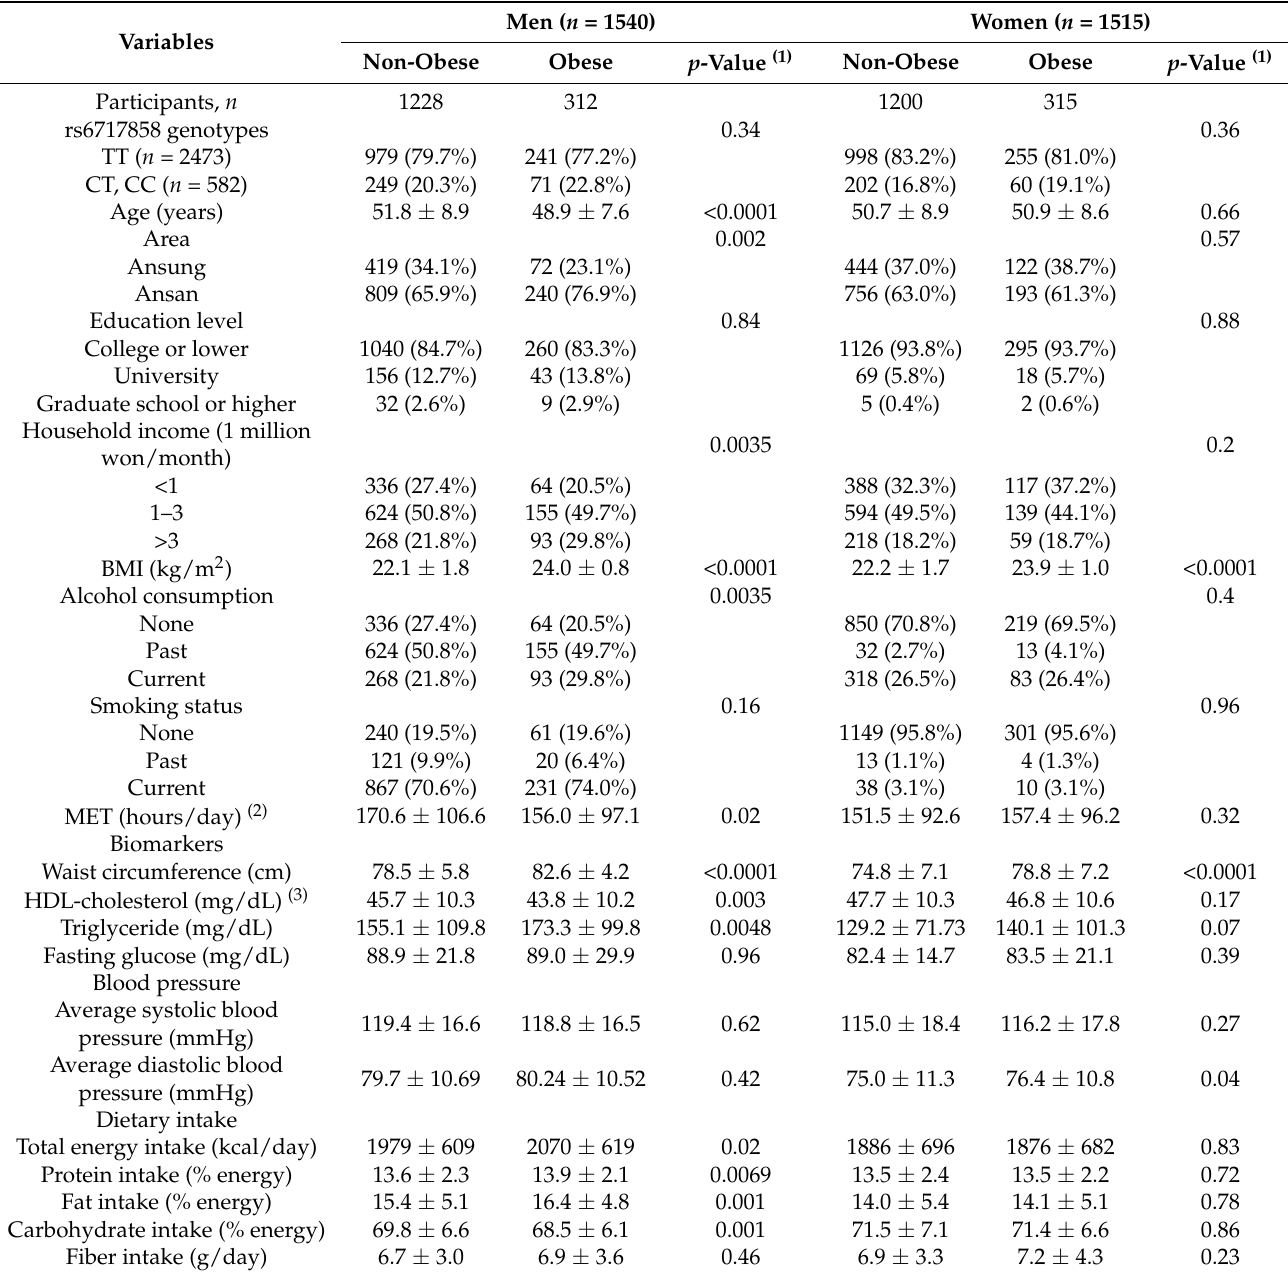
Table 1. General characteristics, biomarkers, and dietary intake of study participants based on sex and obesity